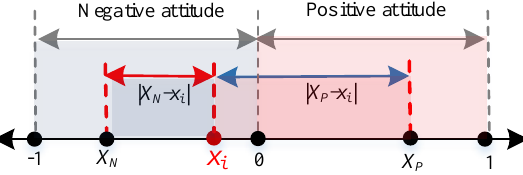
Figure 2. Diagram of social mainstream revenue with negative attitude.